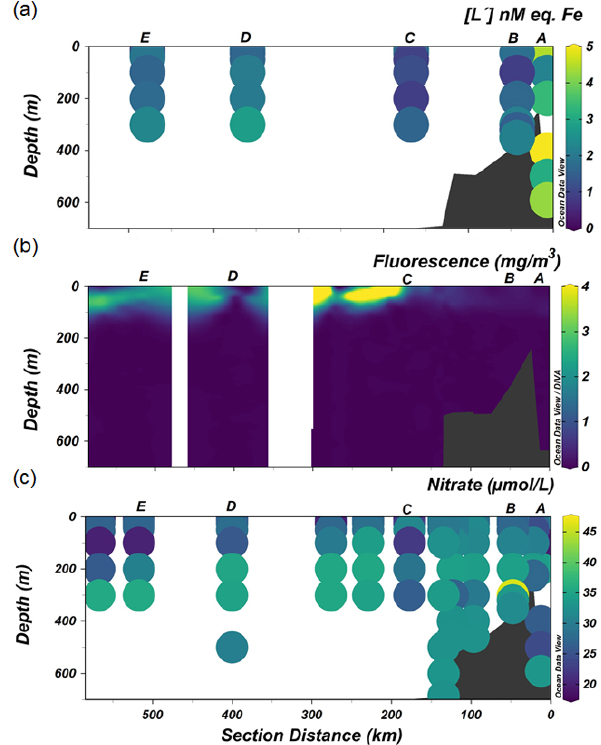
Figure 5. The distribution along the transect shown in Fig. 1 of (a) excess ligand concentrations [ L (cid:48) ], (b) fluorescence and (c) ni-